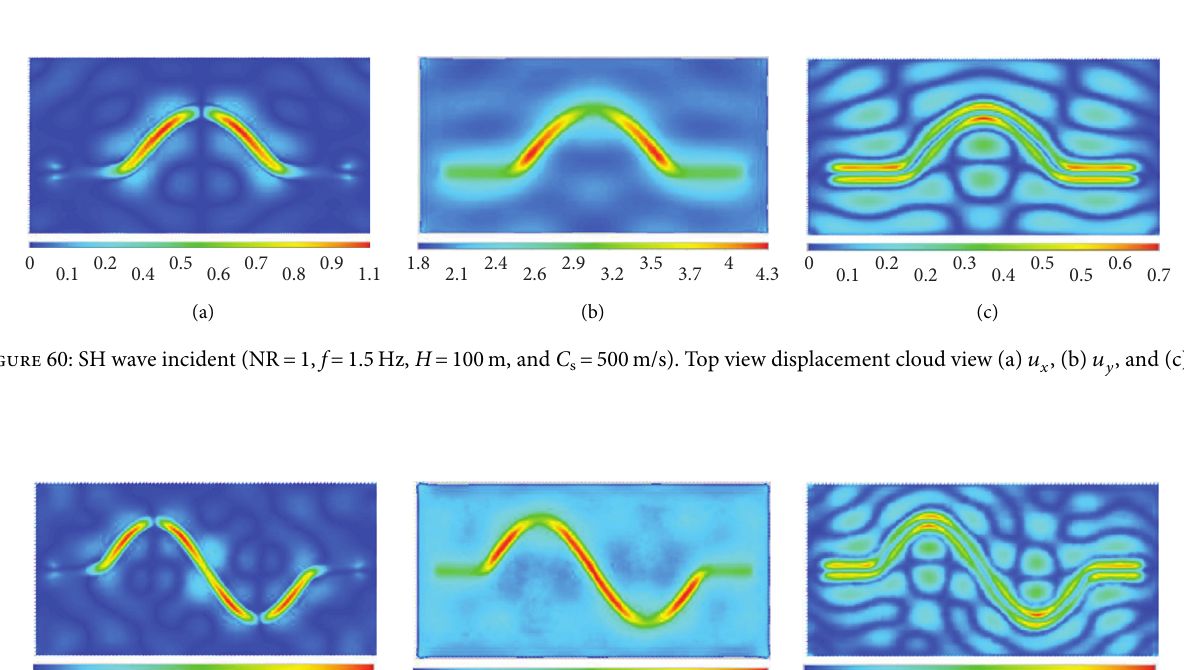
Figure 59: SH wave incident (3D sedimentary hemispheric basin, f � 1.5Hz, R � 100m, and C view (a) u x , (b) u y , and (c) u z .